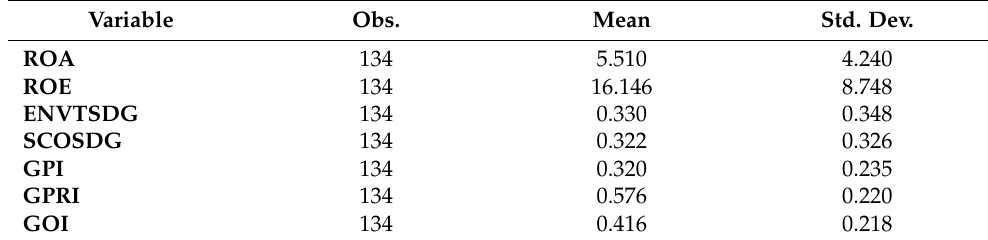
Table 4. Descriptive statistics.